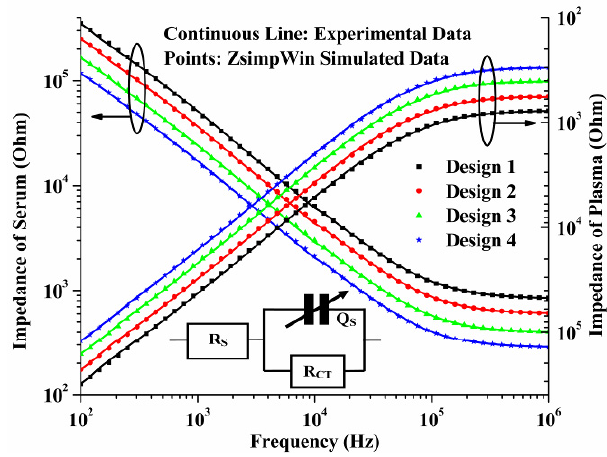
Fig.5: Bode Plot of serum and plasma with its equivalent